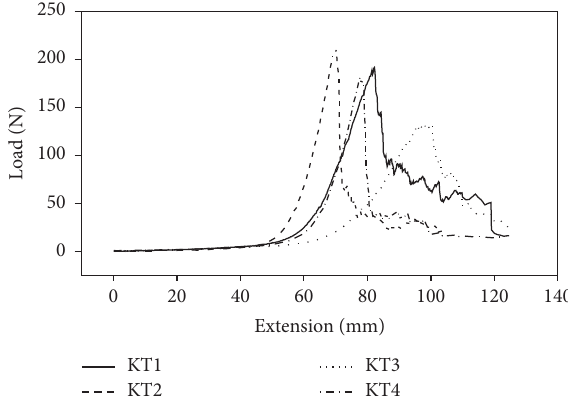
Figure 7: Tensile characteristics of each